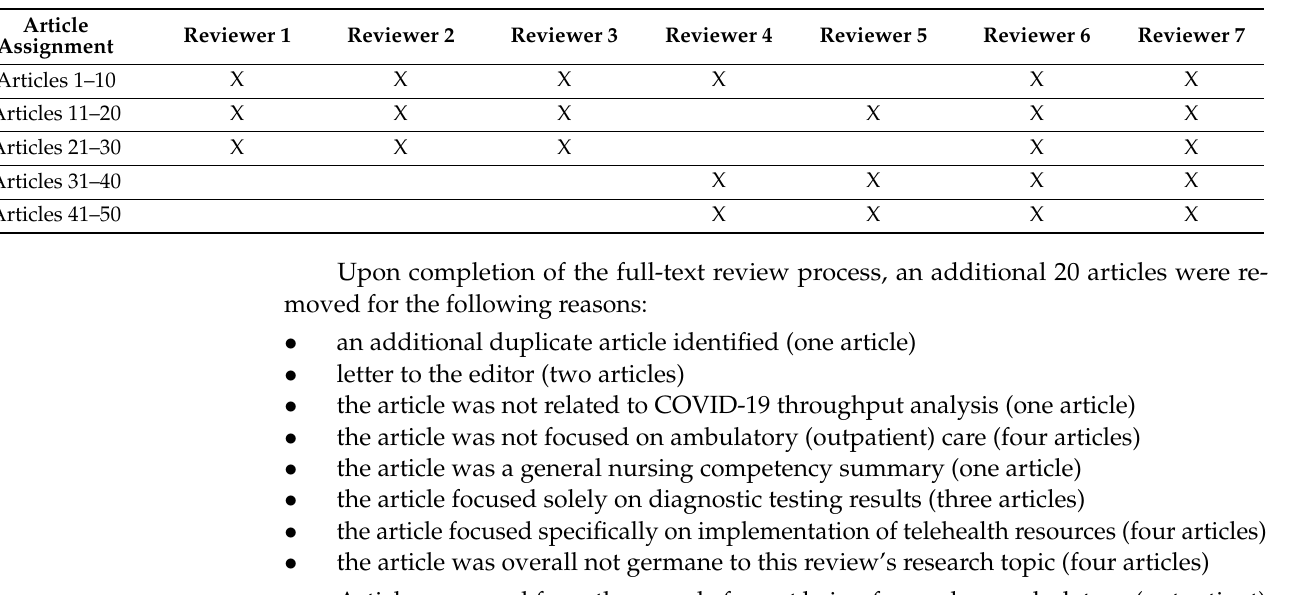
Figure 1. Preferred reporting items for systematic reviews and meta-analysis (PRISMA) figure that demonstrates the study selection process. Table 2. Reviewer assignment of the initial database search findings (full article